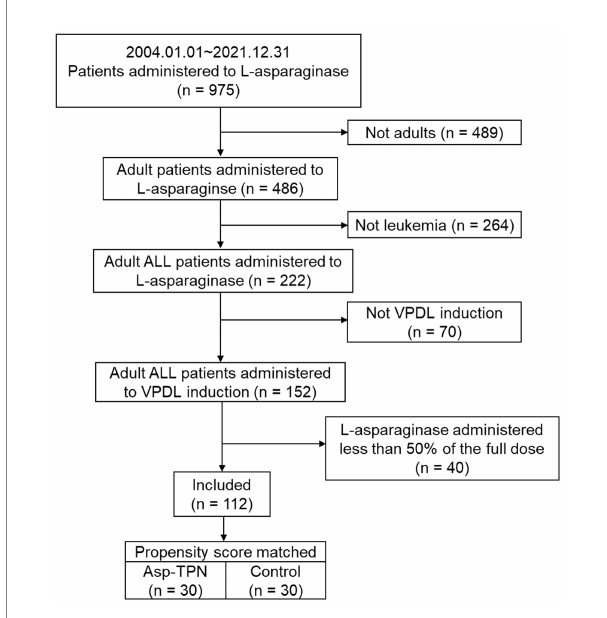
FIGURE 2 Flowchart of the study population. ALL, acute lymphoblastic leukemia; VPDL induction, Vincristine/Prednisolone/ Daunorubicin/L-asparaginase induction regimen; Asp-TPN, aspartic acid-containing total parenteral nutrition.